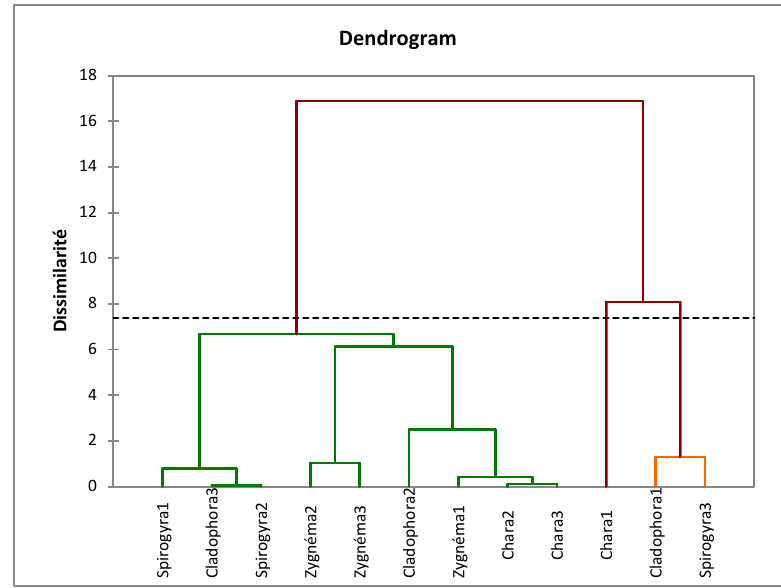
Figure 9. Structure dendrogram of individuals (samples) according to the CAH.